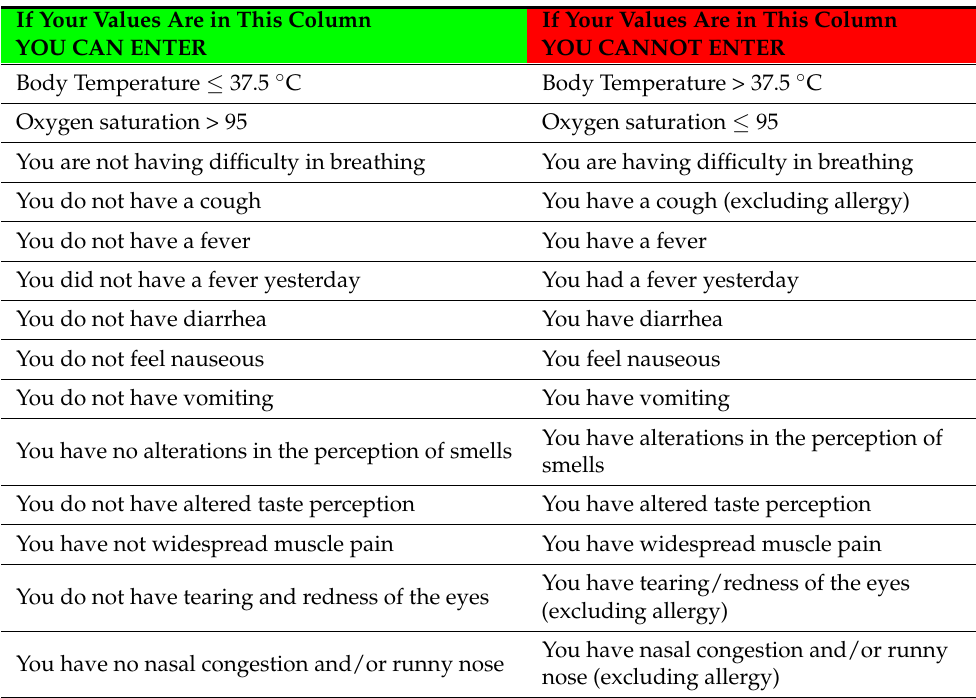
Table 1. Checklist to screen workers before entering the